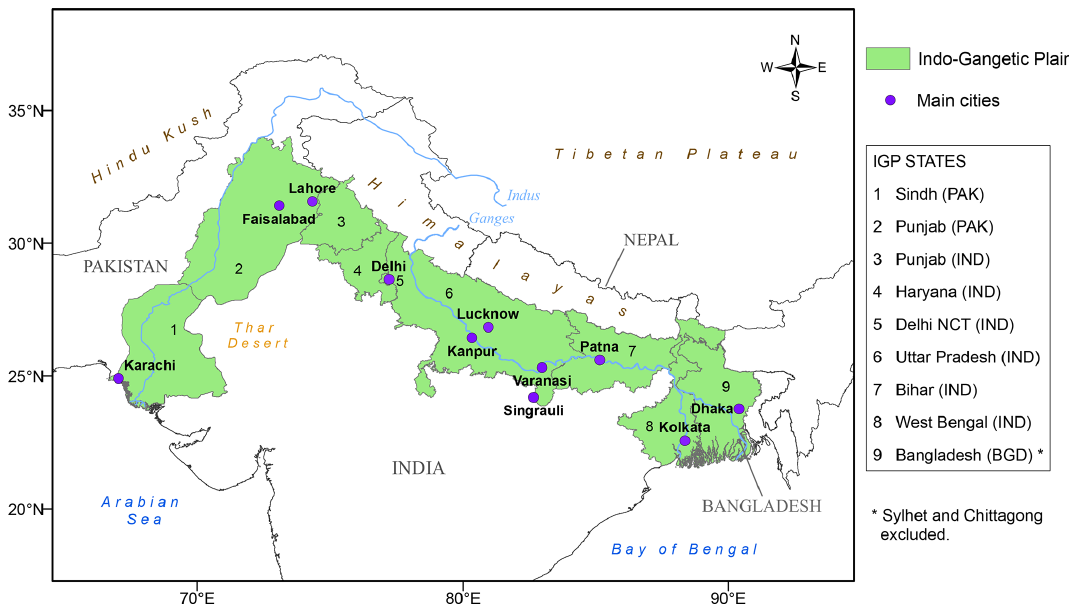
Figure 1. Geographical and administrative features of the Indo-Gangetic Plain (IGP), including Pakistan, India, and Bangladesh. Numbers denote individual IGP states, and purple dots denote the main